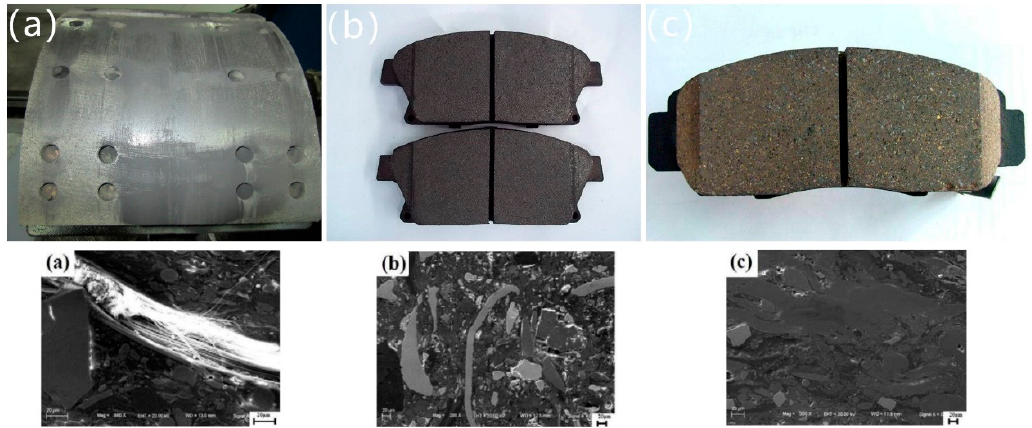
Figure 1. Three kinds of brake pads. ( a ) Semi-metallic brake pads macroscopic appearance and microstructure; ( b ) organic asbestos-free brake pads macroscopic appearance and microstructure; ( c ) ceramic brake pads macroscopic appearance and microstructure.